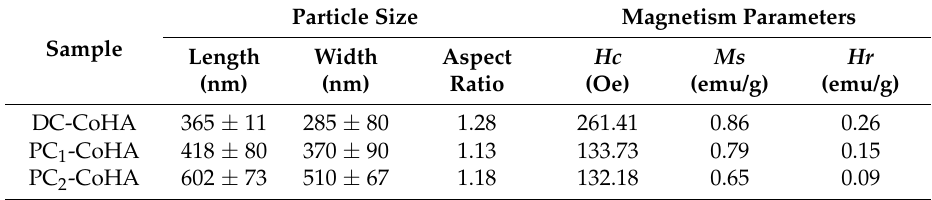
Figure 1. Schematic diagram of direct current and pulse current supply. Table 1. The particles size and magnetism parameters ( Hc , Ms and Mr ) of CoHA.